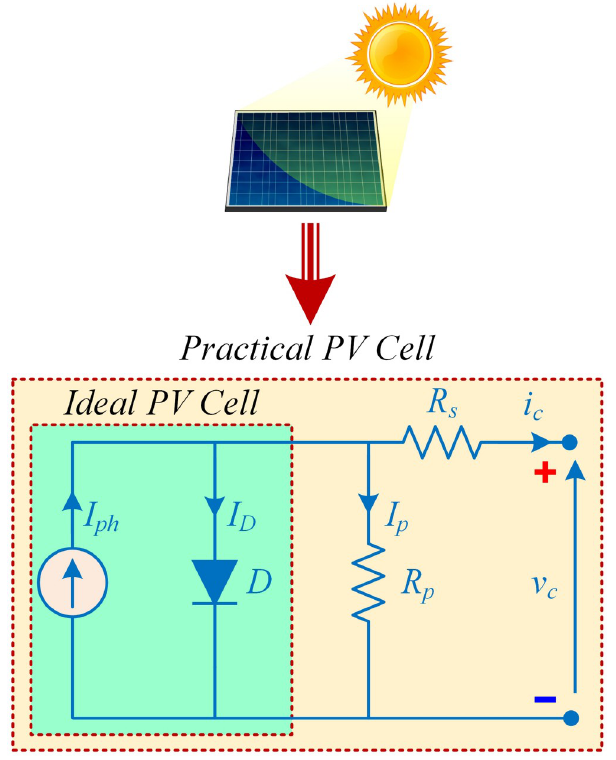
Fig 4. Equivalent single-diode circuit of a PV